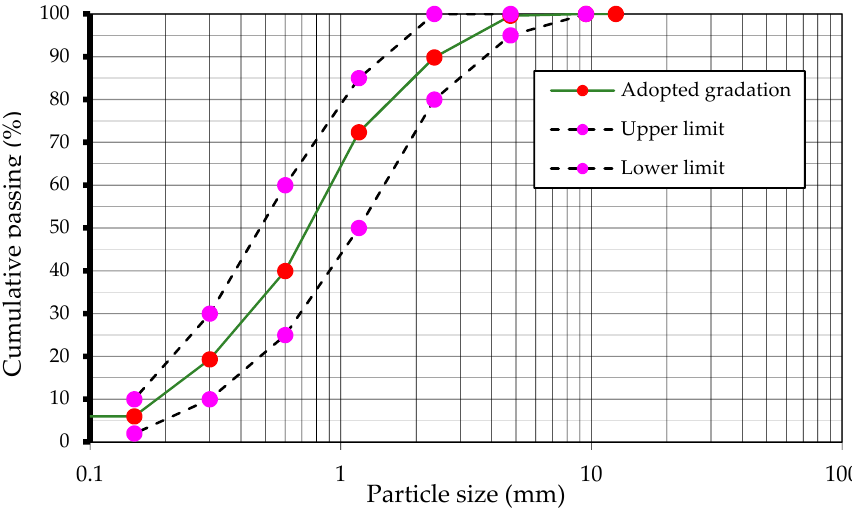
Figure 1. Size distribution curve for aggregate used in the present research.